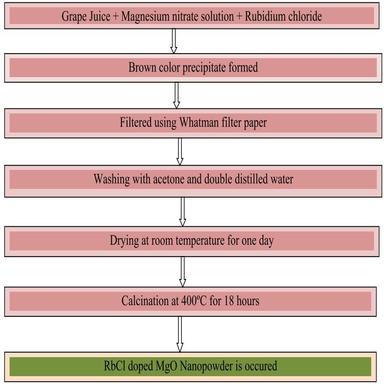
The flow chart for preparing RbCl doped MgO nanoparticles.